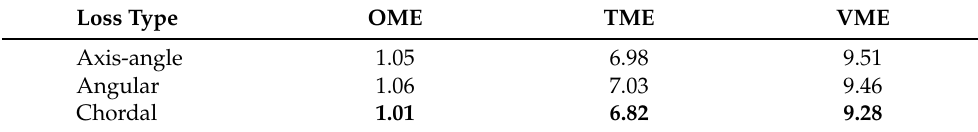
Table 3. Ablation results for orientation losses on Human3.6M. The best results are shown in bold.